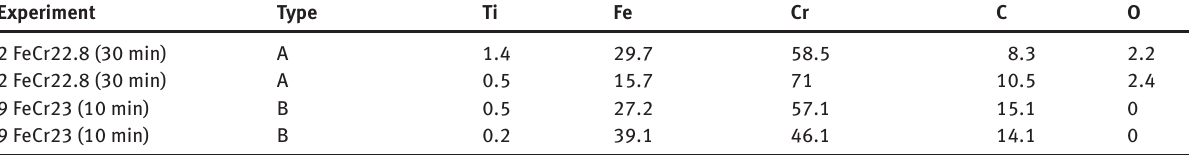
Table V: Analyses of the Cr rich phase found in the experiments (All values in